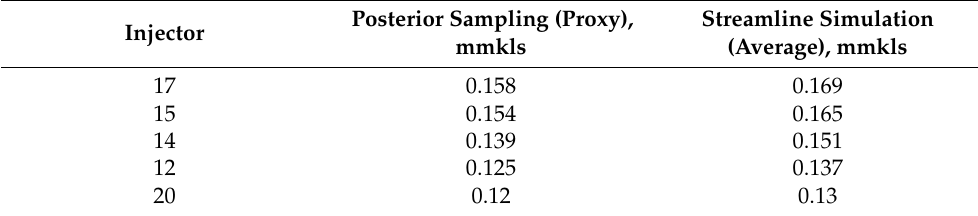
Table 13. Comparison between proxy results from posterior sampling and average incremental oil from numerical simulation for the top 5 candidate